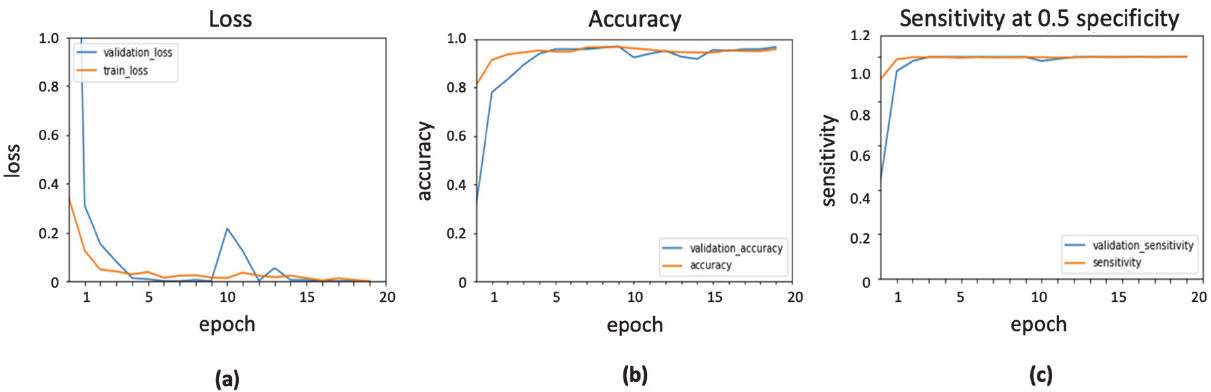
Figure 7. Output obtained using RMSProp optimizer: ( a ) loss function; ( b ) accuracy; ( c ) sensitivity.